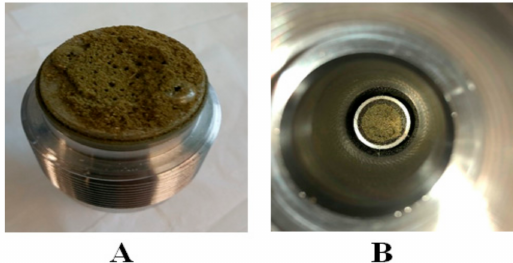
Figure 6. Schematic representation of bottom floor of the sample holding chamber in Helix unit. ( A ): bottom filter was blocked during depressurization of CO 2 from bottom outlet. ( B ): cannabis sample placed at the top of cone.